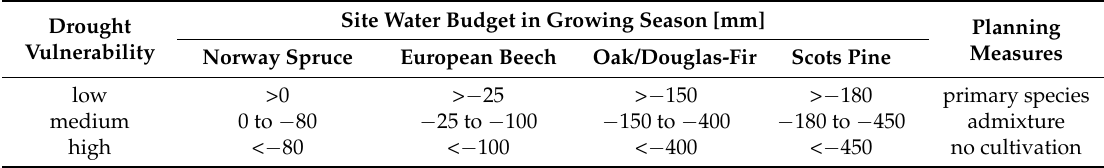
Table 3. Definition of drought vulnerability classes for five major tree species and corresponding planning measures according to [28,53].